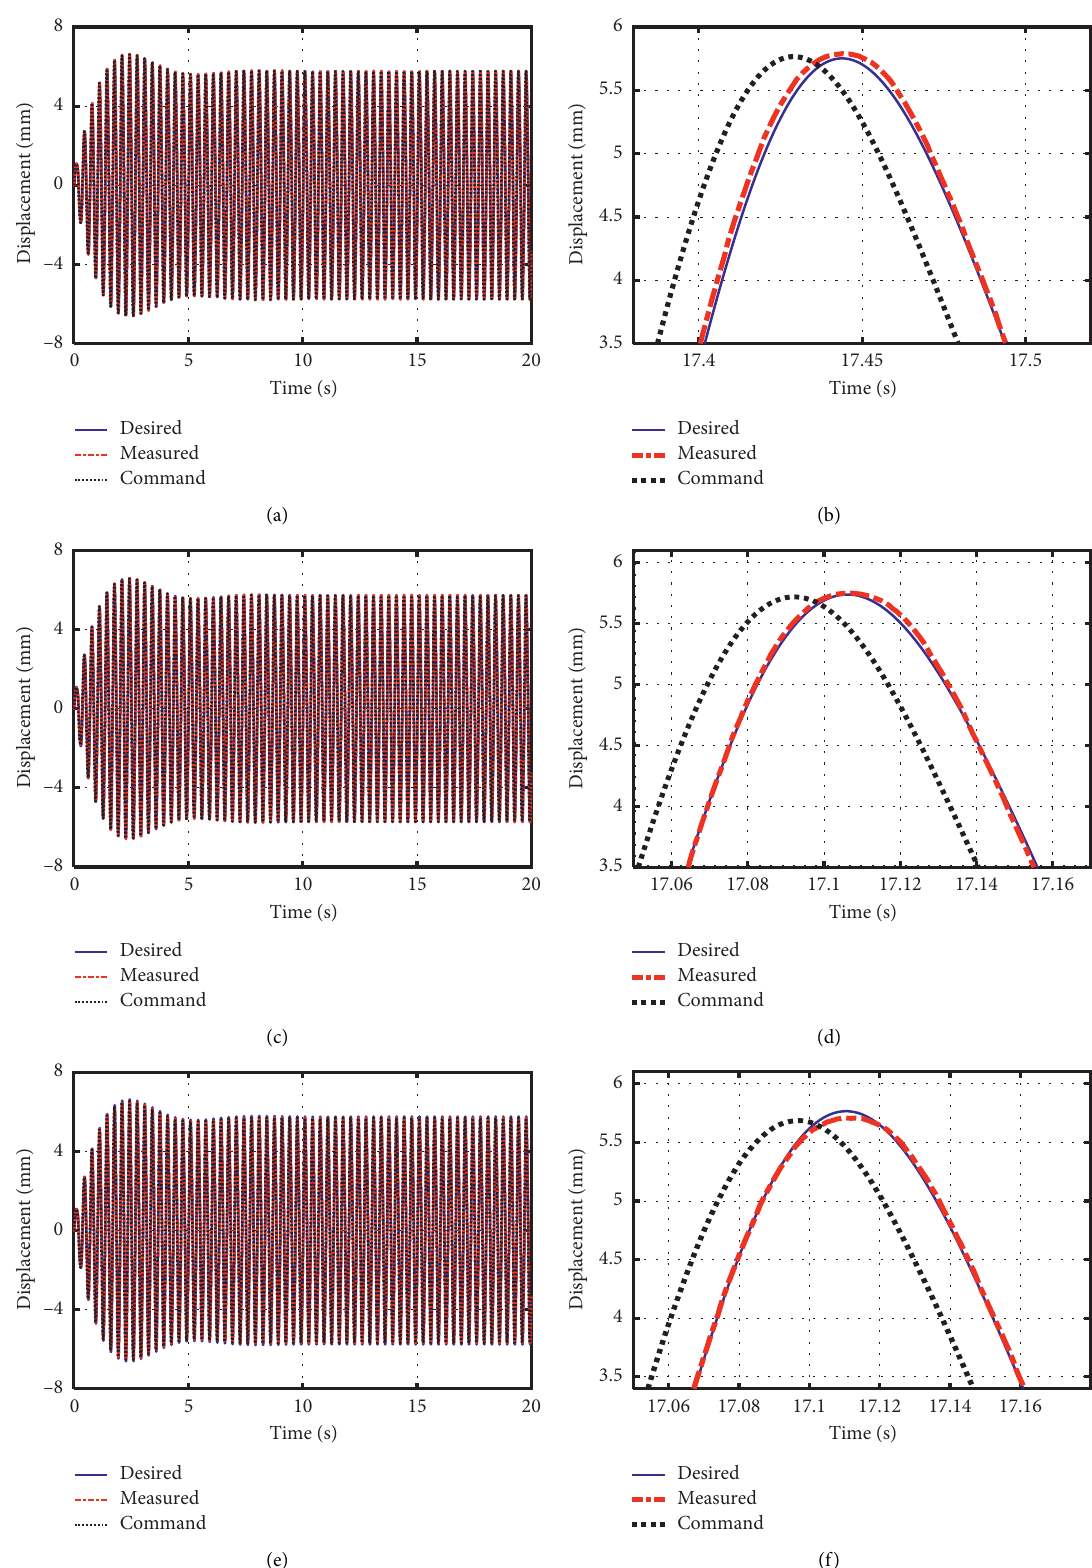
Figure 9: Displacement time histories obtained in RTHS with sinusoidal excitation. (a) Displacements obtained with the PE method. (b) Enlarged view of (a). (c) Displacements obtained with the SADC method. (d) Enlarged view of (c). (e) Displacements obtained with the TADC method. (f) Enlarged view of